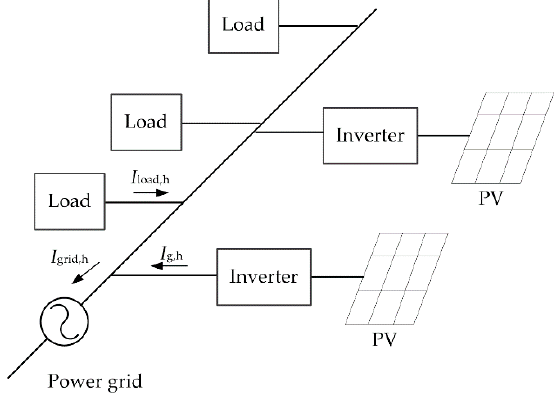
Figure 1. Circuit diagram of microgrid.